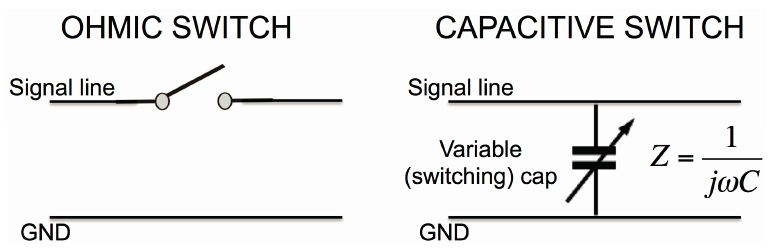
Figure 1. Switching principles for ohmic and capacitive